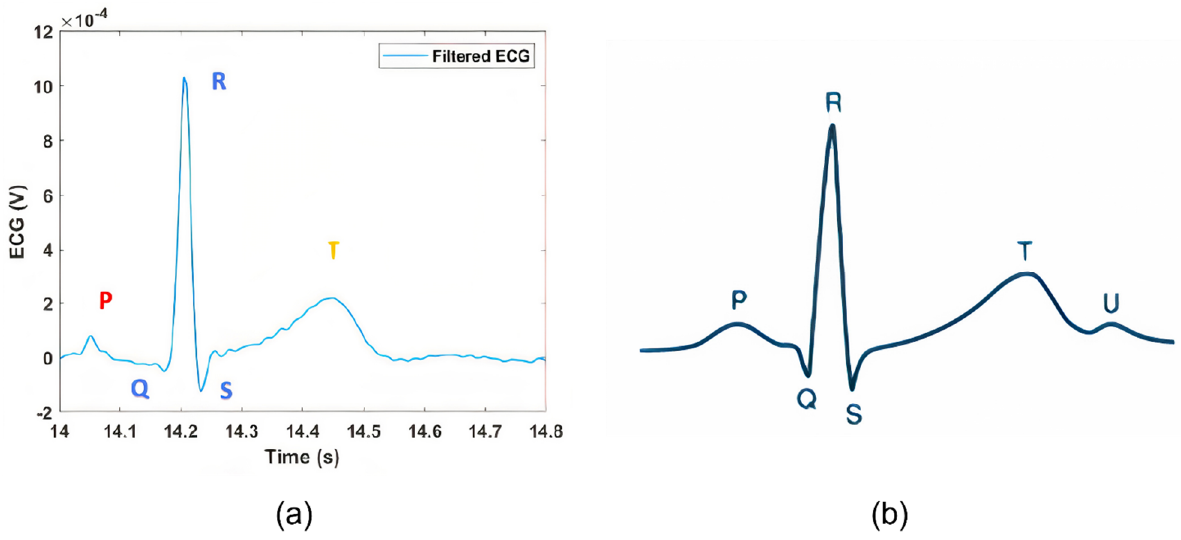
Figure 11. ( a ) Electrodes positioning; ( b ) typical ECG raw trace.